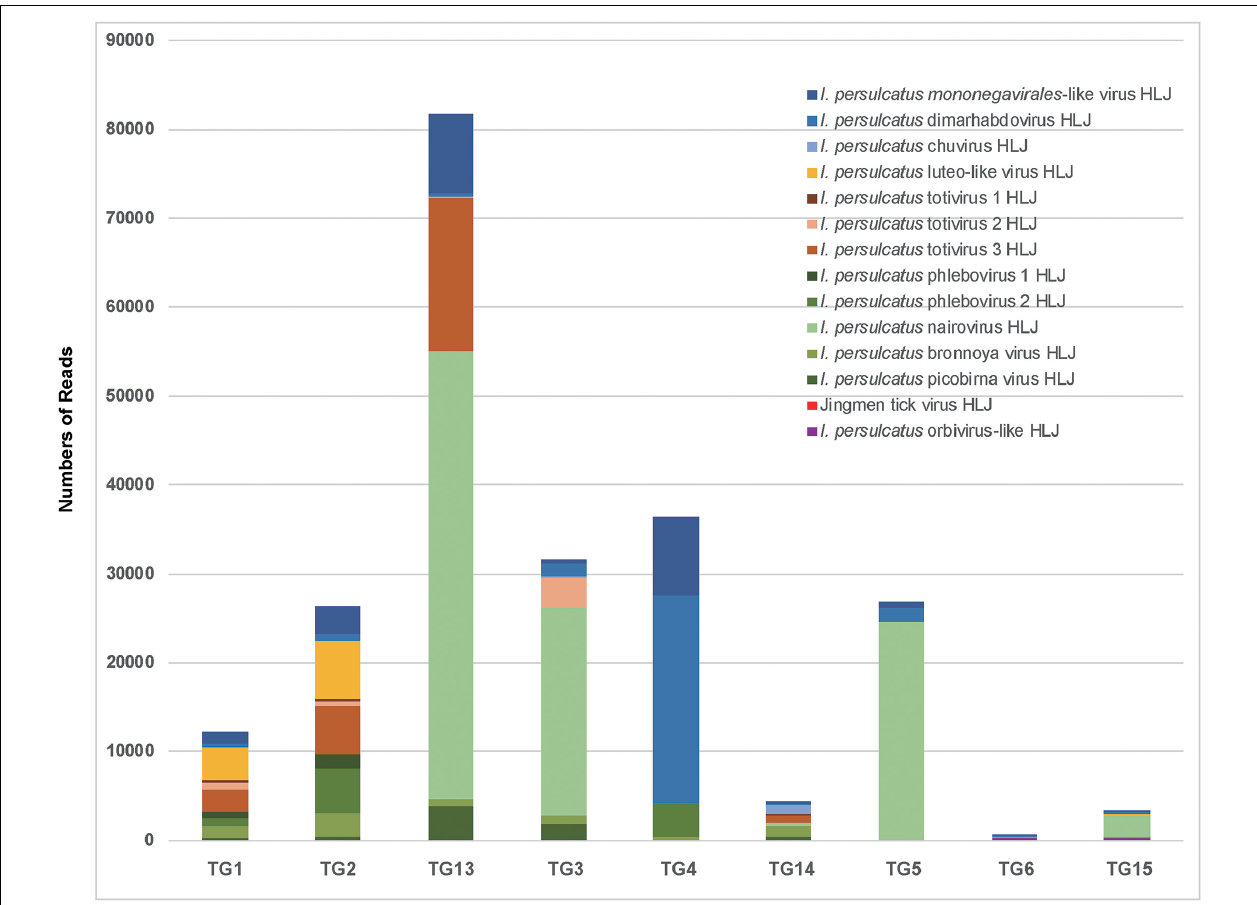
FIGURE 2 | Detection by RNAseq of known and novel viruses in pools of I. persulcatus ticks removed from human patients at Mudanjiang Forestry Central Hospital in Heilongjiang Province, China. Levels of abundance of Jingmen tick virus and 13 newly discovered viruses in flat (pools TG1, TG2, and TG13), partially fed (pools TG3, TG4, and TG14), and fully fed (pools TG5, TG6, and TG15)